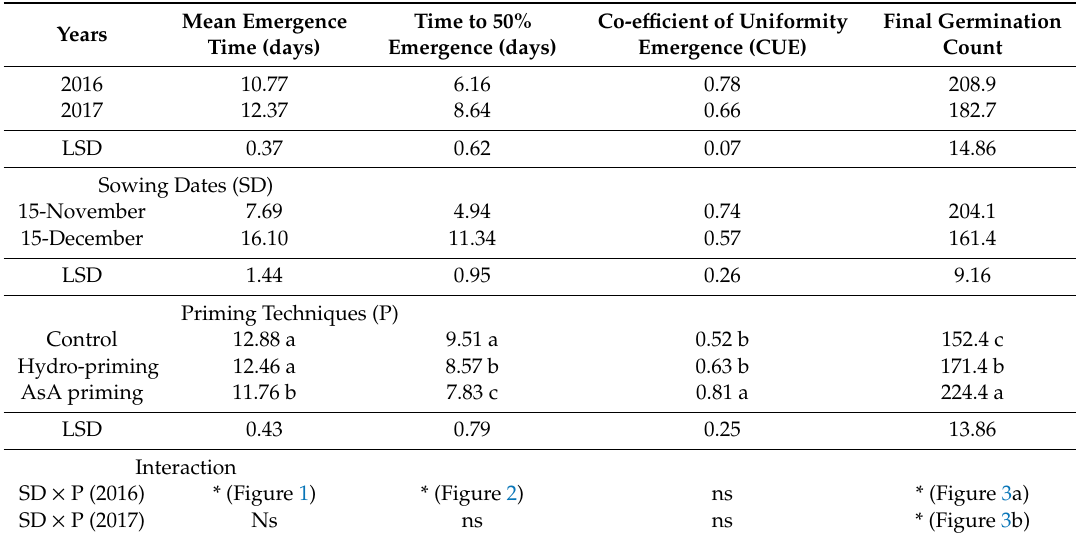
Table 1. Mean comparison of the e ff ect of seed priming and sowing dates on stand establishment of